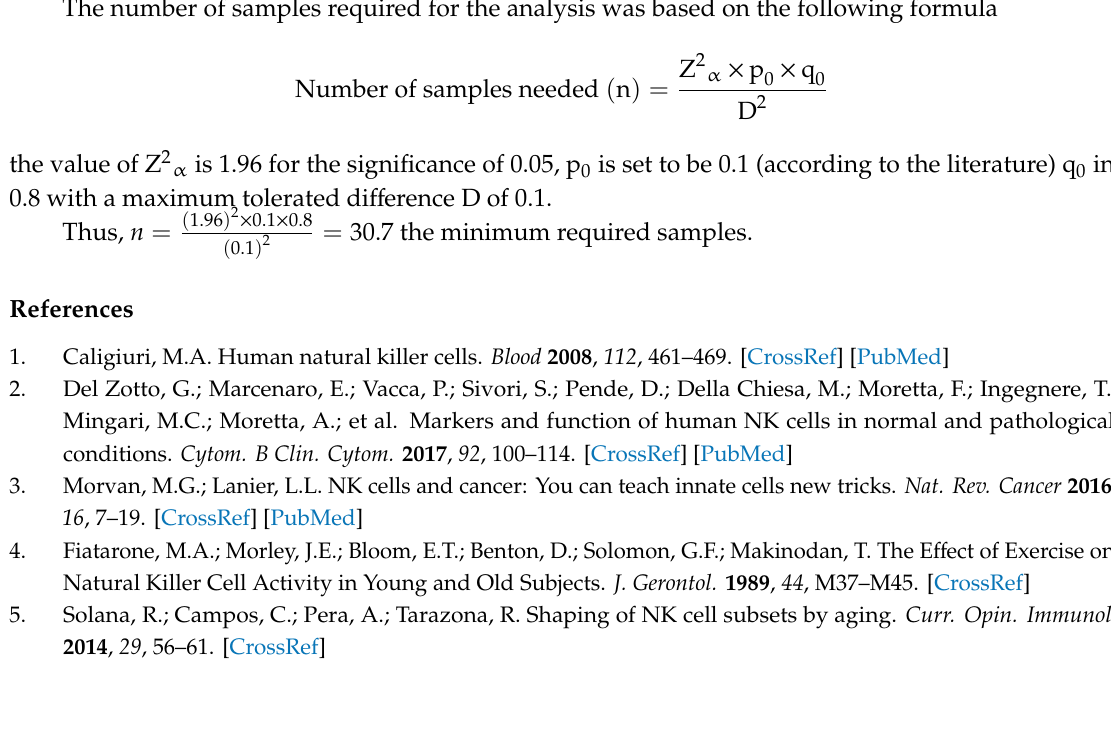
Figure S1: The figure illustrates a standard flow cytometry assessment after NK cell purification from a healthy young adult; 98% of the cells are NK cells, Figure S2: The figure represents the flow cytometry assessment of the di ff erent receptors in typical healthy young adults and a healthy elder individual, Figure S3: E ff ect of fatty acids treatment on the mean fluorescence intensity of CD94, NKG2A, NKG2D, CD158a, CD158b, CD158e1 / 2, CD158f, and CD158i antigens, Figure S4: E ff ect of fatty acids treatment on the mean fluorescence intensity of NKp30, NKp44, NKp46, CD160, CD11b, CD62L, CD69, and CD161 antigens, Table S1: Number of peripheral blood NK cells mm3 and the% purity after separation, Table S2: NK cell markers modulation by fatty acid treatment in cells isolated from the blood of healthy young adults and healthy elder subjects, Table S3: E ff ect of di ff erent concentrations of fatty acid on CD94 expression and cell